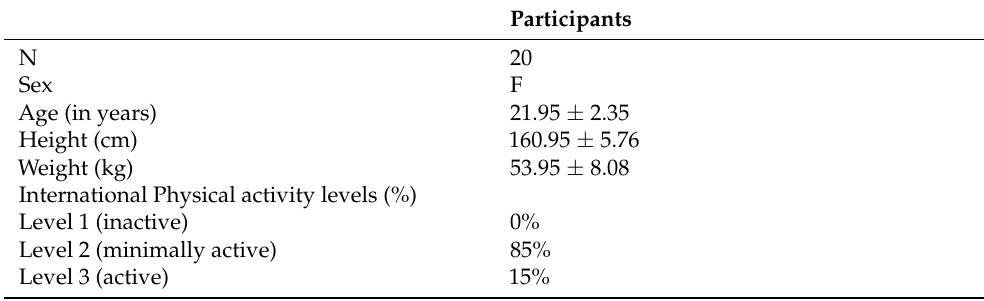
Table 1. Descriptive characteristics of participants: (mean ± SD).